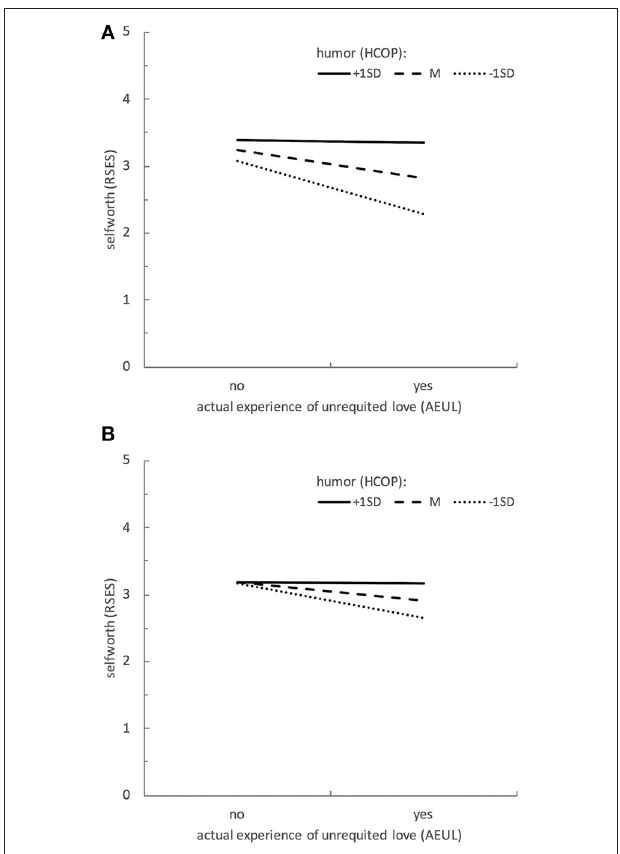
FIGURE 1 | Visualization of moderation effects (Data of Model 3): Predicting Self-esteem (RSES) from actuality of unrequited love (AEUL) and Humorous Change of Perspective (HCOP) (A) step 1: no covariate considered in the model (B) step 2: Flexible Goal Adjustment (FGA) added as covariate in the model, the figure displays results for FGA fixed to the current sample’s mean